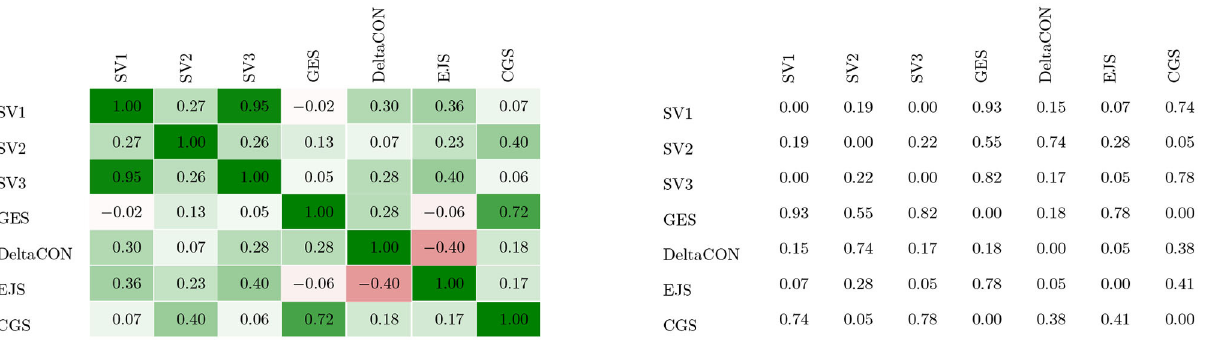
TABLE 5 | Rank correlations of the orderings of subject areas according to the average similarities obtained for the corresponding INs of language pairs where the similarities are computed by means of seven different similarity measures.